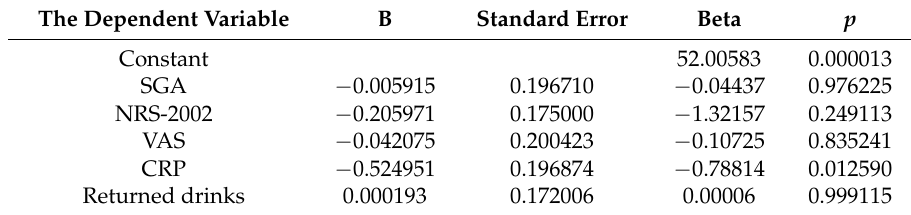
Table 3. The multivariate regression. The dependent variable: albumin.